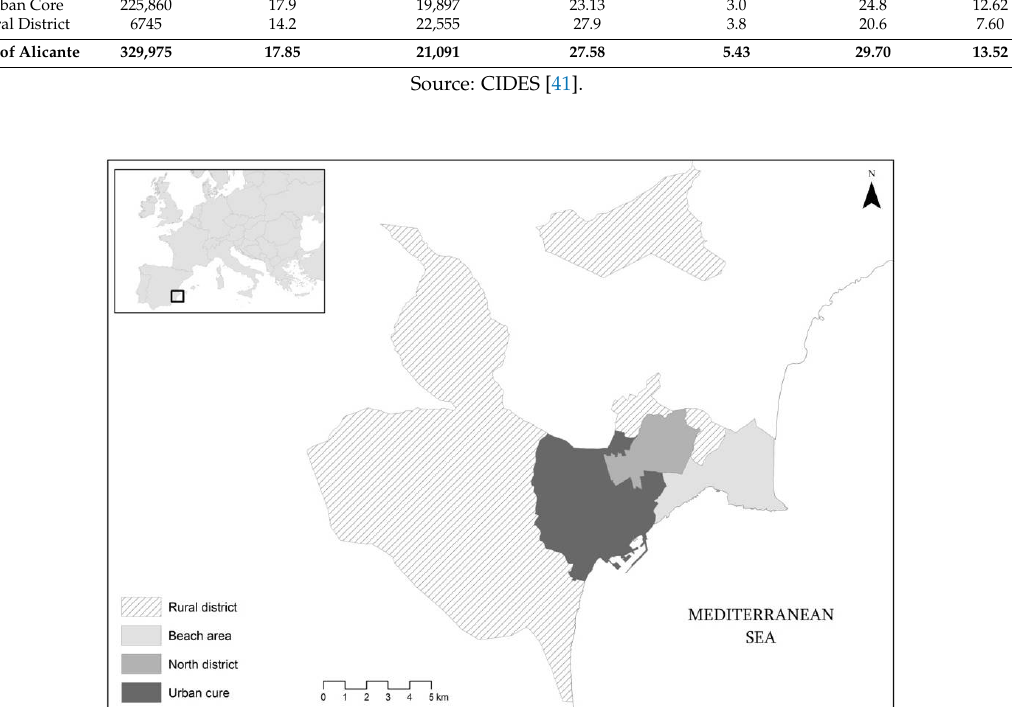
Figure 1. Study area. Own Elaboration.